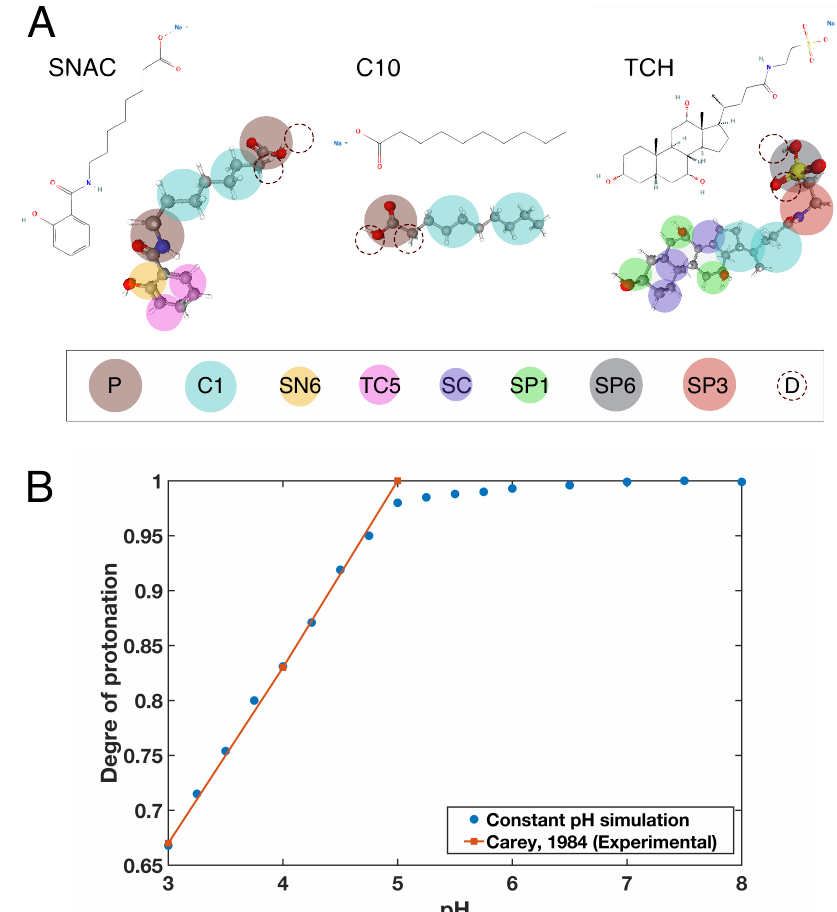
Figure 1. ( A ) Mapping of the beads on the all-atomistic representation of SNAC, sodium caprate (C10) and taurocholate (TCH). D-beads are virtual particles introduced specifically for titratable molecules. ( B ) Titration curve for taurocholate calculated from constant-pH MD simulations (blue dots) and compared to experimentally observed values by Carey et al.